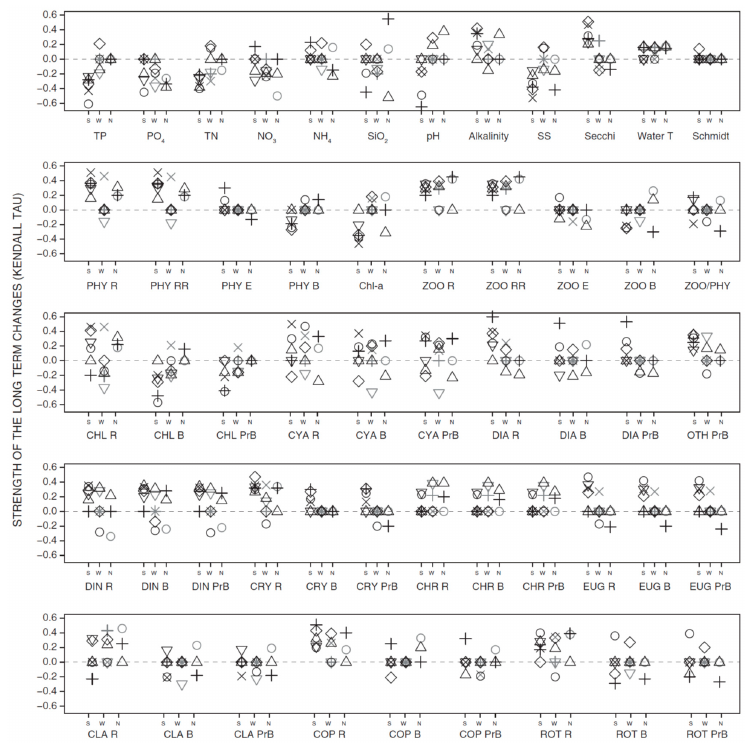
Figure A7. Summary of monotonic long-term trends in lake and plankton variables analysed for summer. For details see Figure 4.